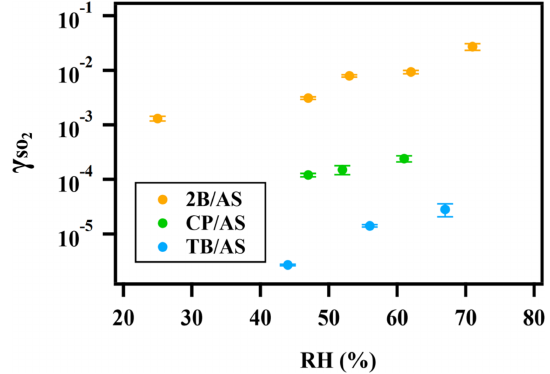
Figure 2. Exponential relationship between γ SO ammonium sulfate aerosol containing 2-butanone peroxide (2B), cumene hydroperoxide (CP), and tert-butyl hydroperoxide